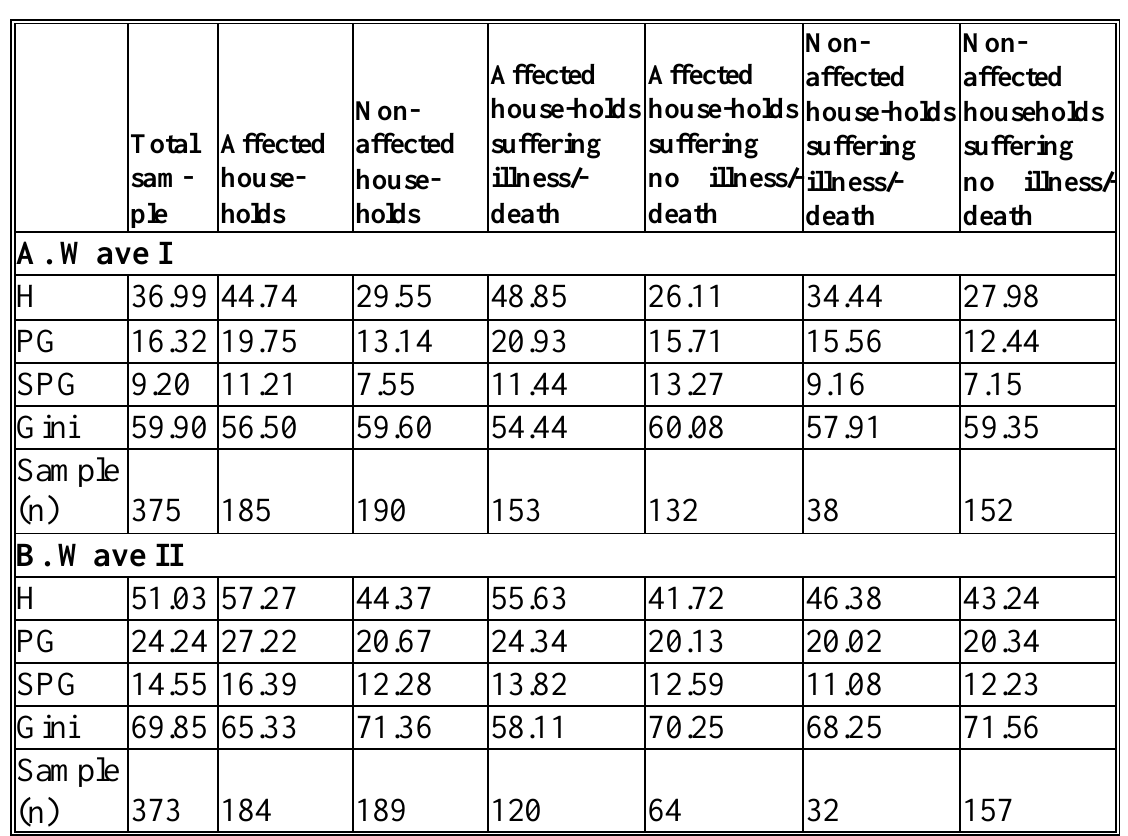
Estimates of the headcount poverty index (h), poverty gap measure (pg), squared poverty gap index (spg) and gini- coefficient for affected and non-affected